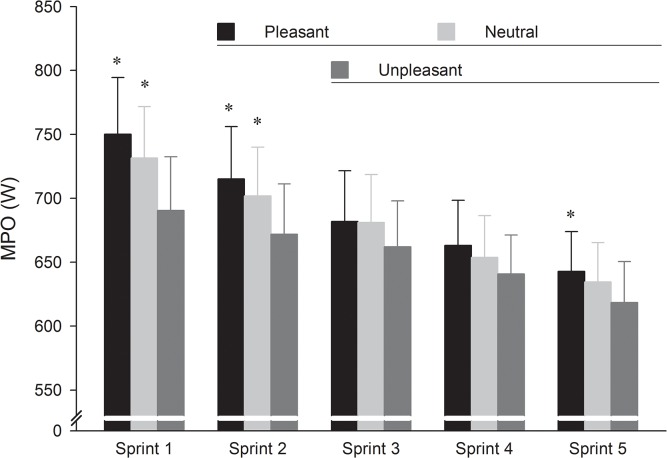
Mean (and standard error) across the pictures category and sprints for mean power output (MPO).When compared to the first sprint, MPO decreased significantly (horizontal line) from the second sprint in the neutral (grey bars) and pleasant (white bars) sessions and from the third sprint in the unpleasant (black bars) session. * Significantly higher compared to the unpleasant condition (p < 0.05).